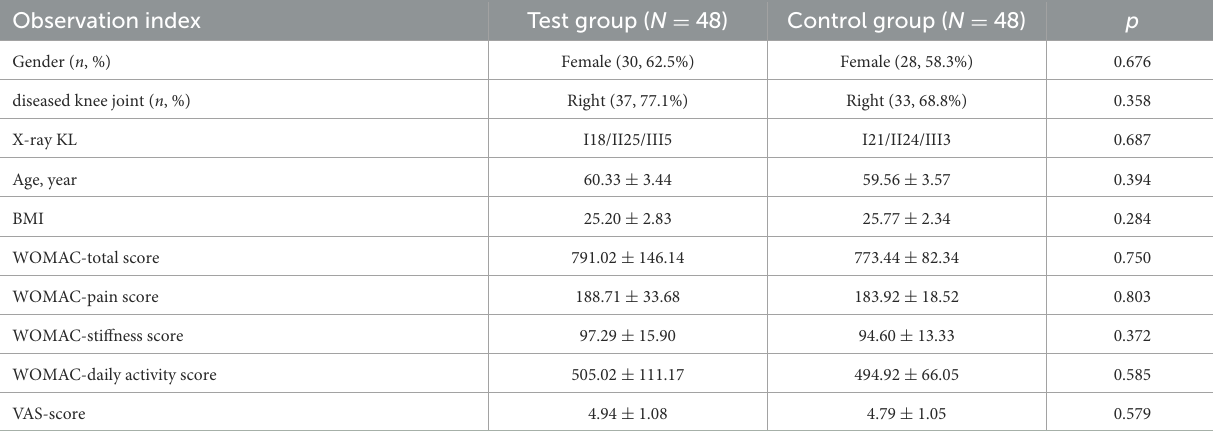
TABLE 2 Comparison of baseline data between the two groups (M ±